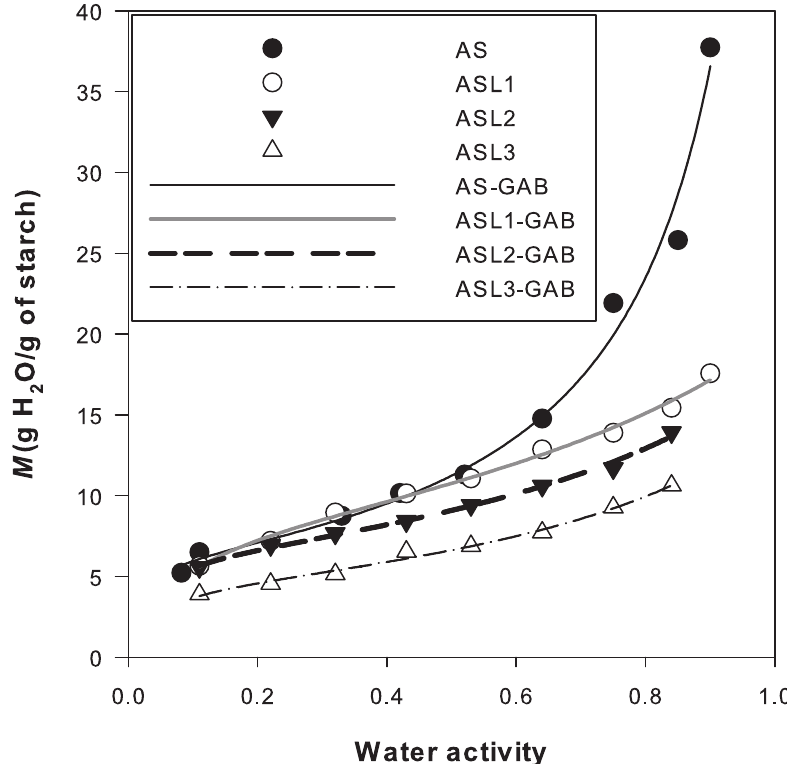
Figure 3. Water adsorption isotherms of native (AS) and modified amaranth starches (ASL1, ASL2 and ASL3) prepared at 25 ◦ C. The solid and dashed lines show the fitting of the GAB model.